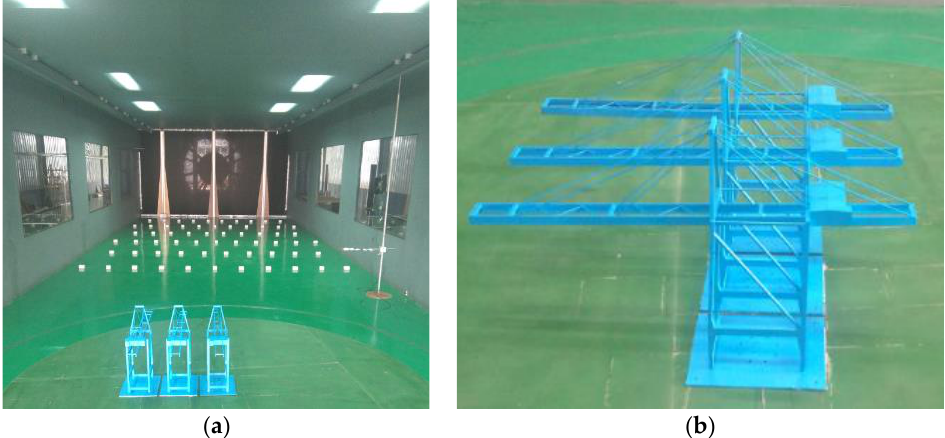
Figure 3. Photos of wind tunnel tests: ( a ) wind tunnel test arrangement; and ( b ) group-arranged rigid models.